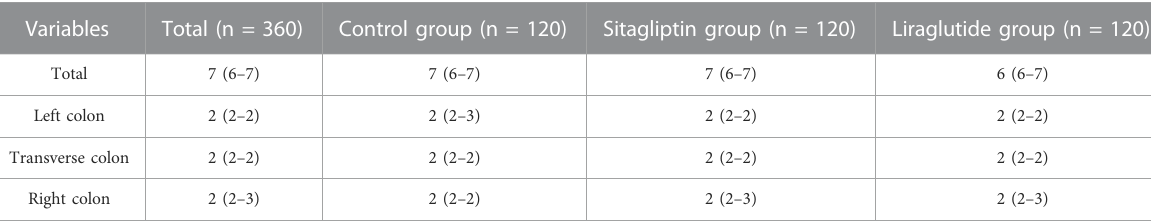
TABLE 2 The BBPS of the participants in the control, sitagliptin, and liraglutide groups. Variables